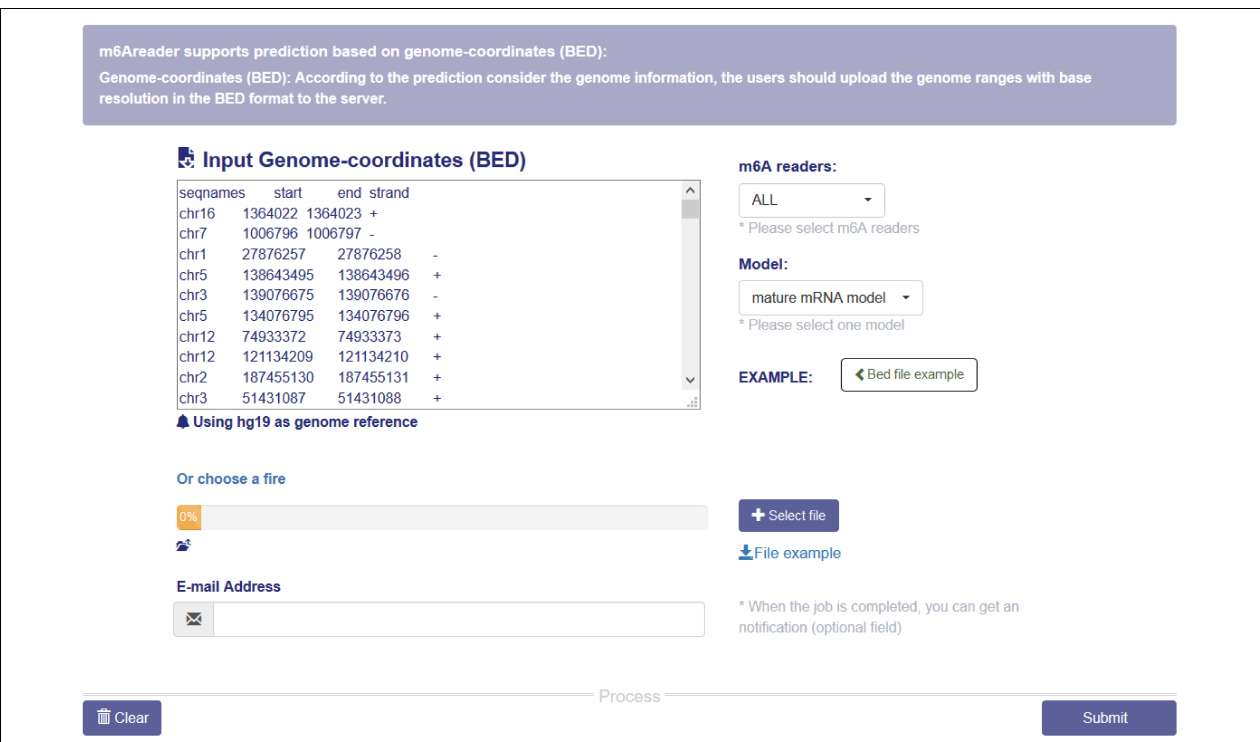
FIGURE 7 | m 6 A reader web server. The web server takes genome ranges in BED format as the input, and supports prediction for the target sites of six m 6 A readers (YTHDC1, YTHDC2, YTHDF1, YTHDF2 and YTHDF3 and EIF3A). All the materials used in the project, including the training data and codes, are also available on the